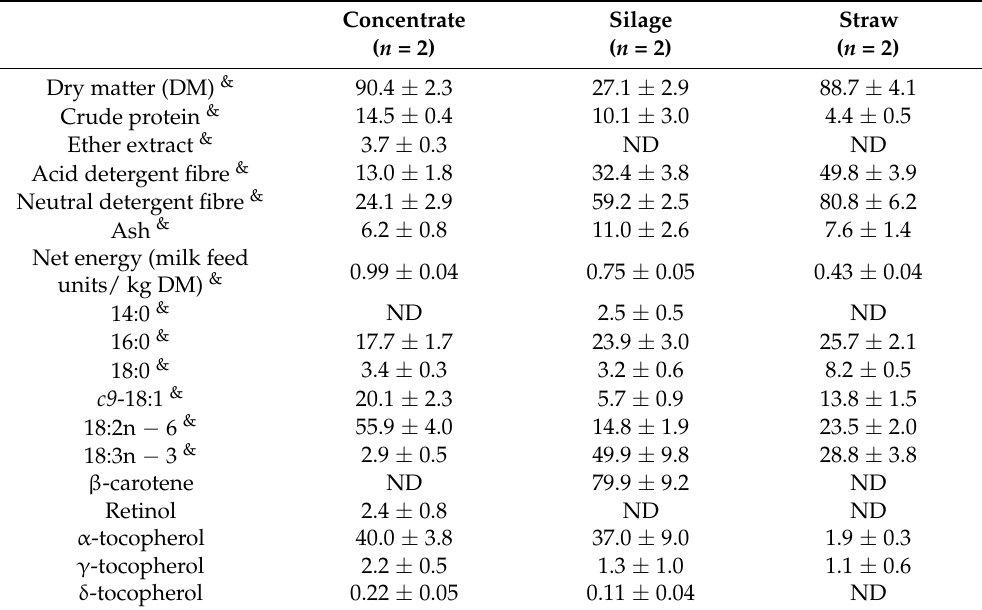
Table 1. Proximate composition (percentage of dry matter) & , major fatty acids (percentage of total fatty acids) & , and fat-soluble vitamins concentrations ( µ g/g of dry matter) of the animal feeds used for fattening the young